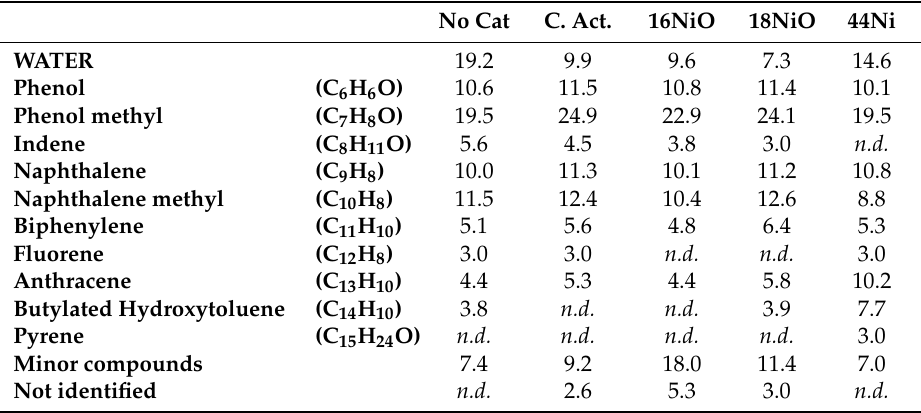
Table 3. Composition of pyrolysis liquids (%